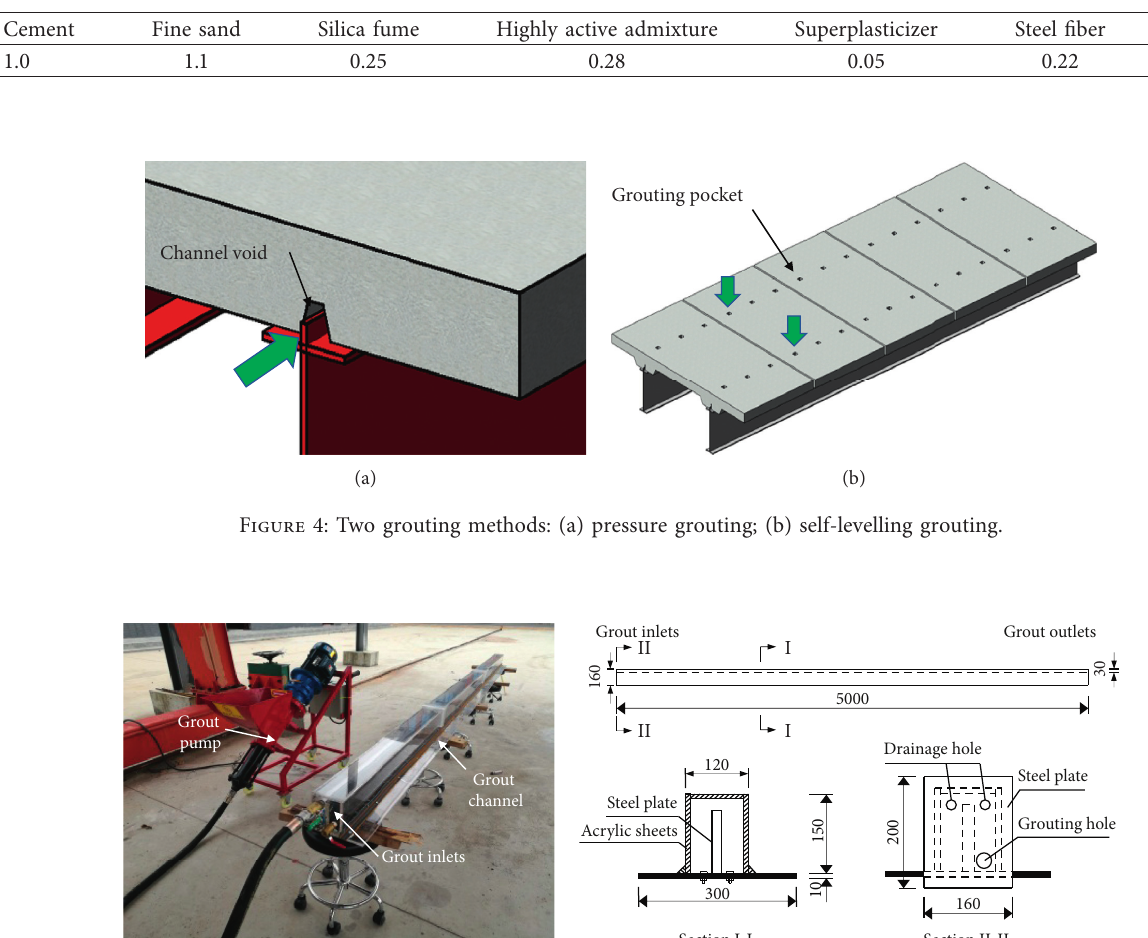
Table 1: Relative weight ratios to cement in the mix design.